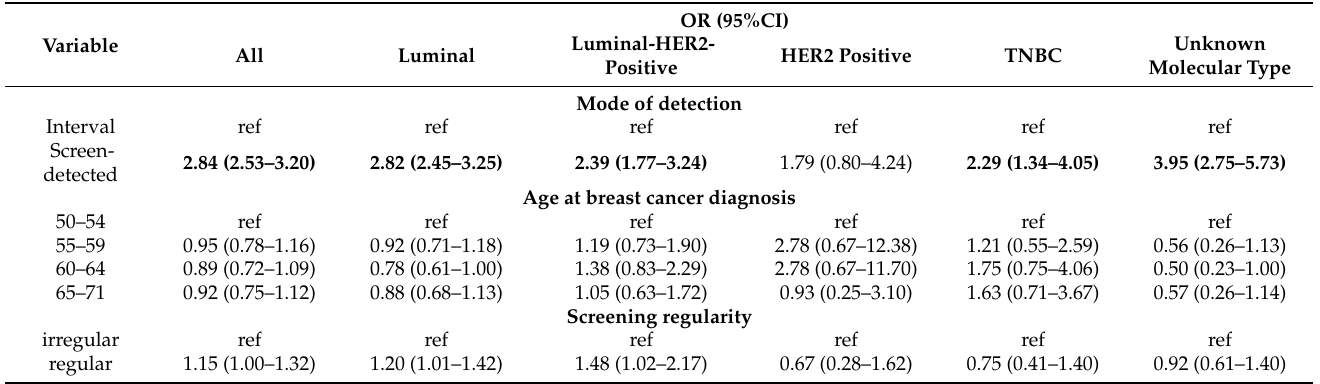
Table 3. Multivariable model for the comparison of the likelihood of early-stage breast cancer at diagnosis for screen-detected and interval breast cancers ( n = 12,115).